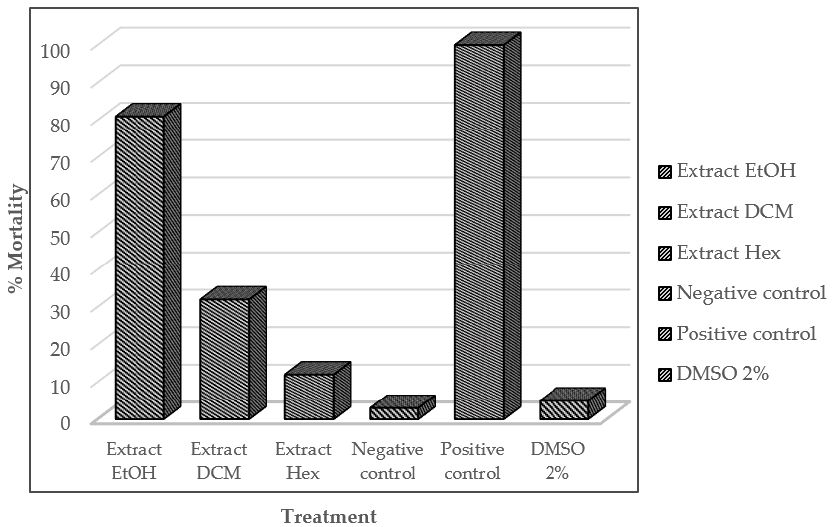
Figure 1. Mortality percentage of organic extracts of S. graminifolia against S. frugiperda larvae.